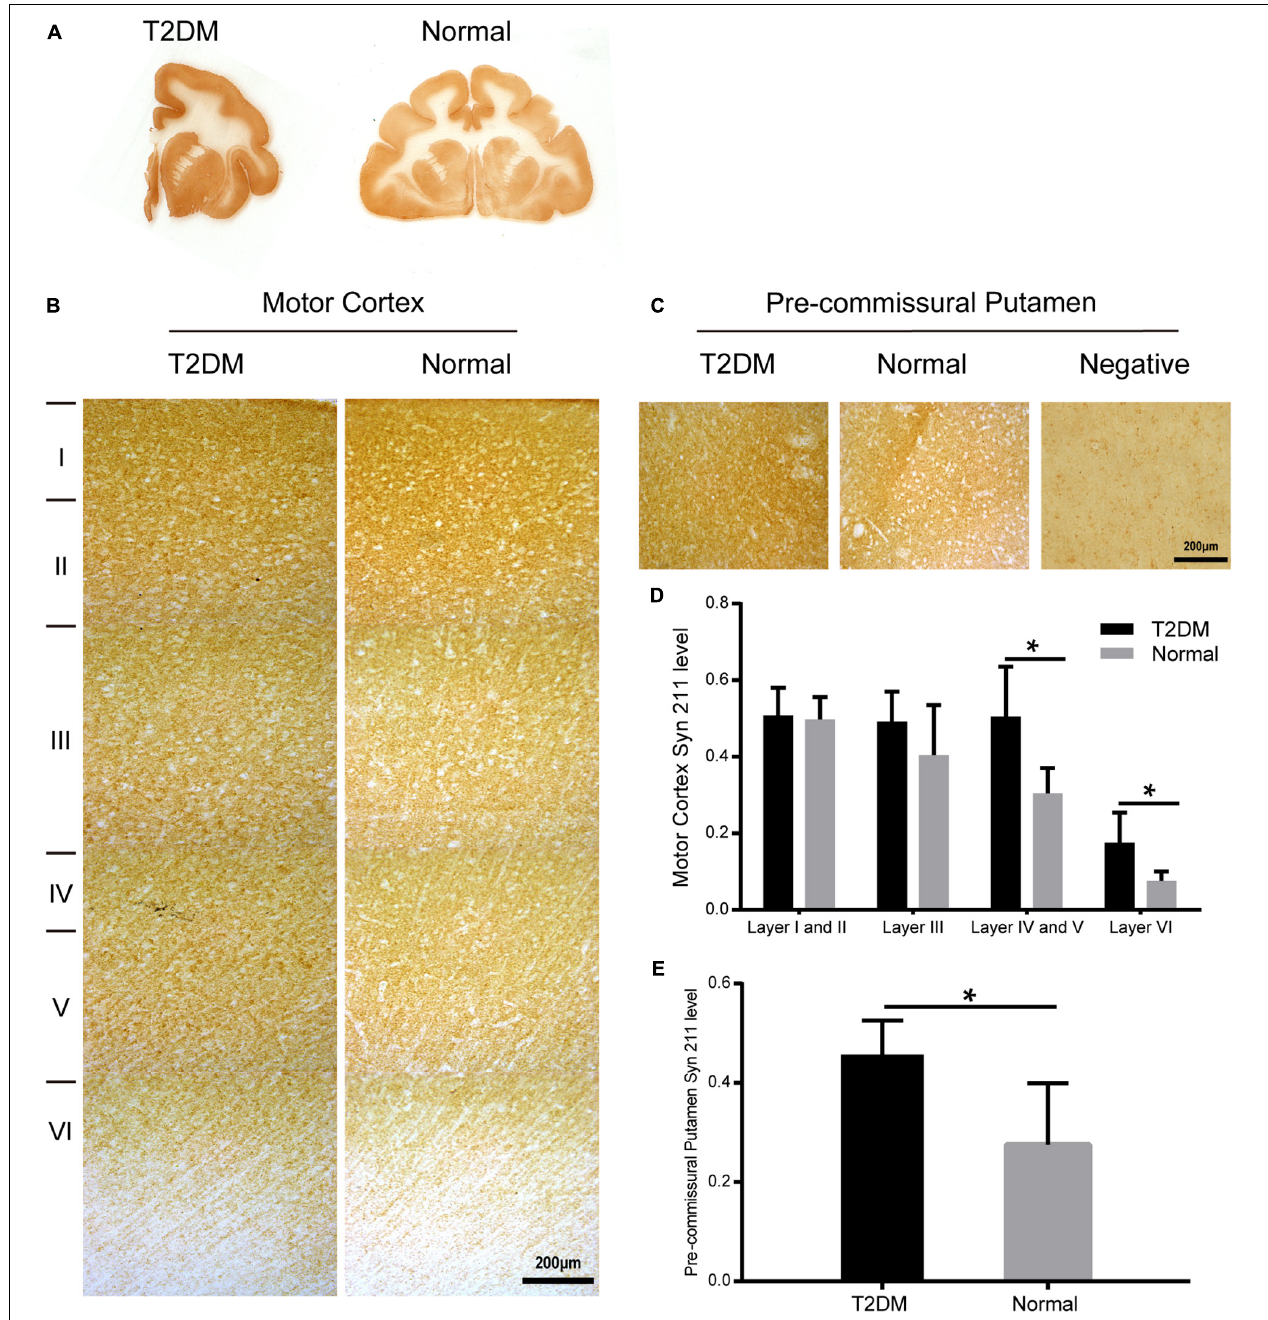
FIGURE 6 | α -Synuclein in the motor cortex and the pre-commissural putamen of diabetic and normal monkeys. Immunohistochemistry for α -synuclein (Syn 211) in the motor cortex marked with estimated cortical layers (B) and in the pre-commissural putamen (C) of a T2DM monkey (left) and an age-matched normal monkeys (right). Macro-scanned images of α -synuclein stained brain sections (A) . A negative control image without the primary antibody incubation was also shown (right, in C ). High power images were also shown in Supplementary Figure S2 . Scale bars = 200 µ m in (B,C) . Quantitative analysis of immunohistochemical intensity of α -synuclein in the motor cortex (D) and in the pre-commissural putamen (E) : Data is represented with the mean ± SE ( n = 5 ∼ 7), * p <